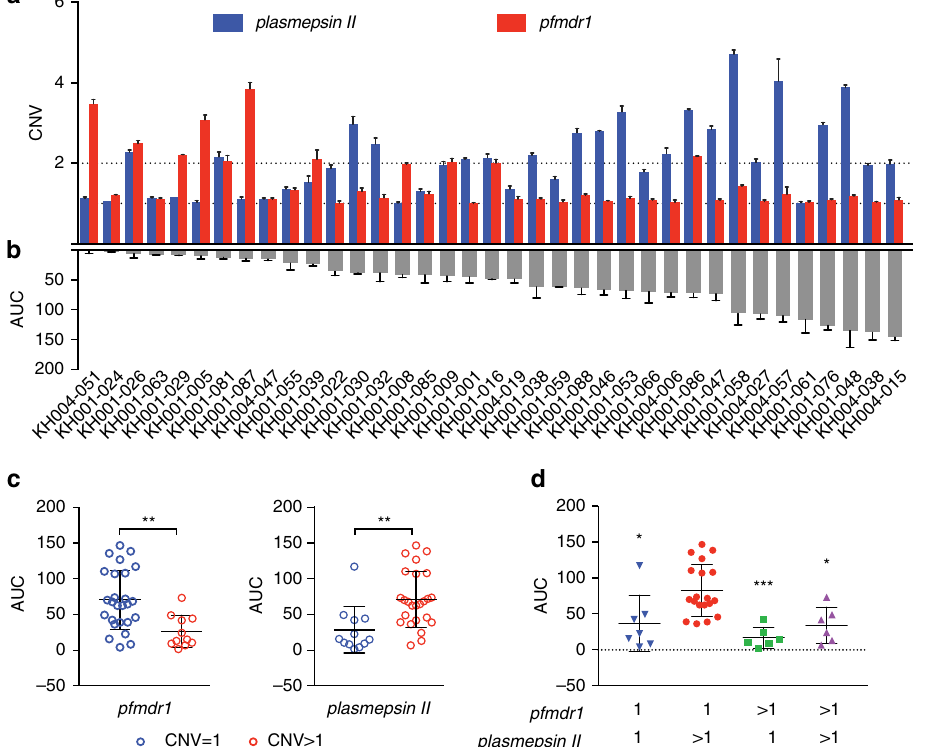
Fig. 3 AUC correlates overall with plasmepsin II copy numbers but there are exceptions. a shows CNVs for plasmepsin II (blue) and pfmdr1 (red) that were estimated based upon average read depth of whole-genome sequencing data ( + s.d.) and con fi rmed by quantitative real-time polymerase chain reaction. b shows the Area Under the Curve (AUC) for the parasite lines tested ( N = 3, mean + s.d.). c shows the distribution of all parasite lines binned into CNV of 1 (blue) or> 1 (red, average>1.6) for pfmdr1 or plasmepsin II , relative to the AUC values, to show the negative correlation for pfmdr1 (unpaired Student ’ s t -test, p = 0.0021, ** p<0.01) and the positive correlation for plasmepsin II ( p = 0.0023). d Combining pfmdr1 and plasmepsin II CNVs, only parasites with pfmdr1 = 1 and plasmepsin II >1 CNVs are signi fi cantly different than the other combinations in regards to the AUC (one-way ANOVA, Tukey corrected). * p <0.05, ** p <0.01. Each data point in c and d represents the mean of three independent assays run in triplicate. The overall mean and s.d. is shown with black